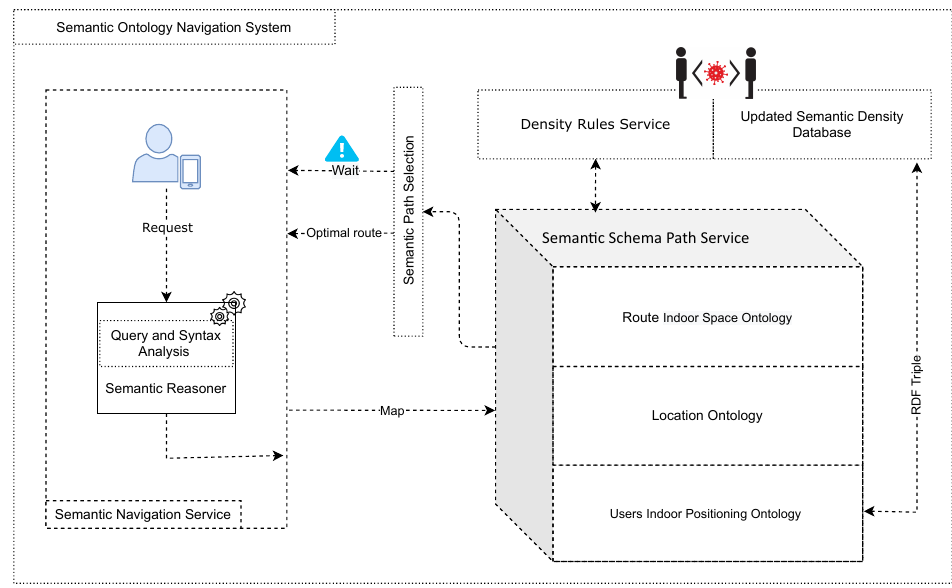
Figure 3. Semantic indoor navigation